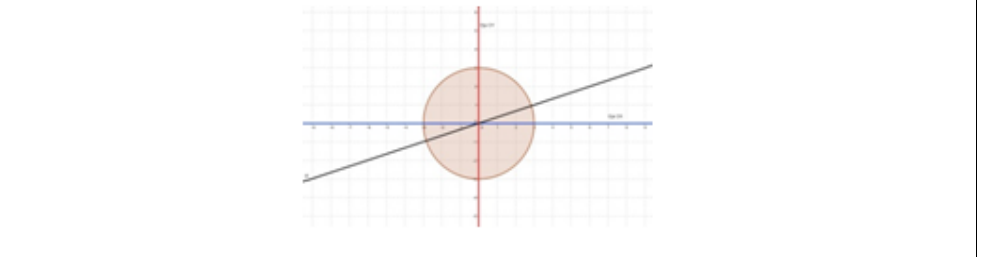
Figure 5. Structuring phase